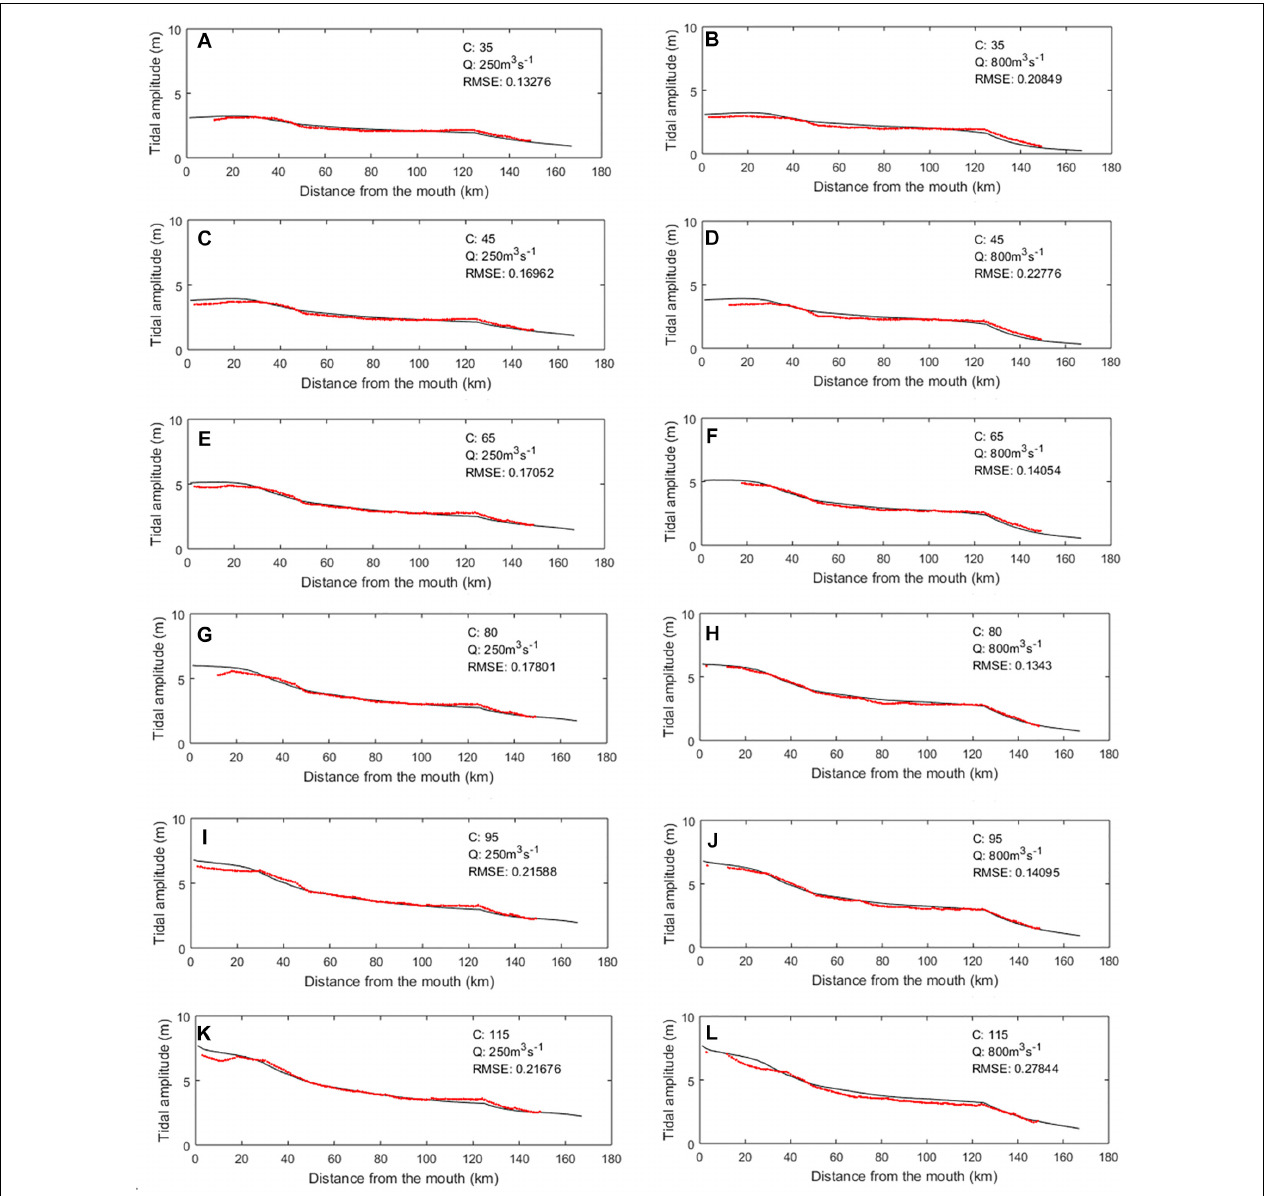
FIGURE 4 | Simulated tidal amplitude profiles along the Seine estuary under varying discharges (Q) and tidal coefficients (C). The black lines are simulated by C-GEM while the red dots correspond to averaged profiles based on long term discharge chronicles. Panels (A–L) correspond to different combinations of values of Q and